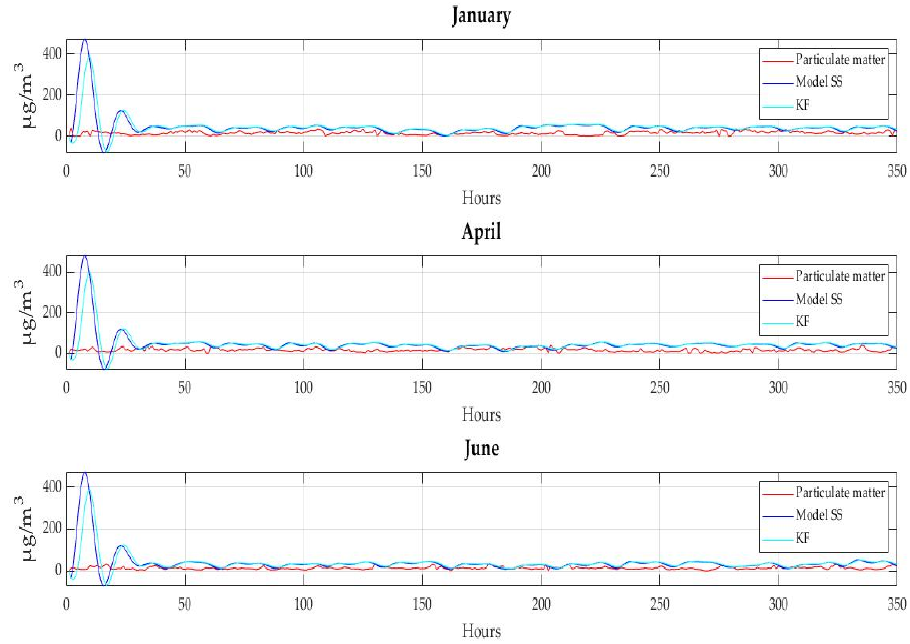
Figure 13. Validation of the model and the filter in the south of Valle de Aburrá.